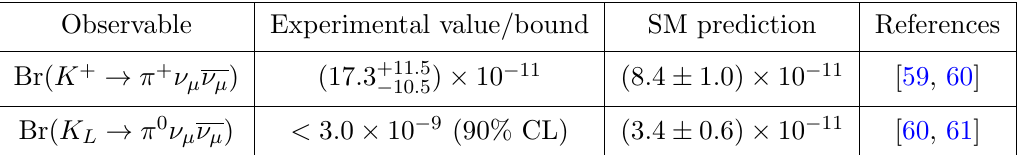
Table 6 . R -correlated observables for single-mediator K ( (cid:3) )